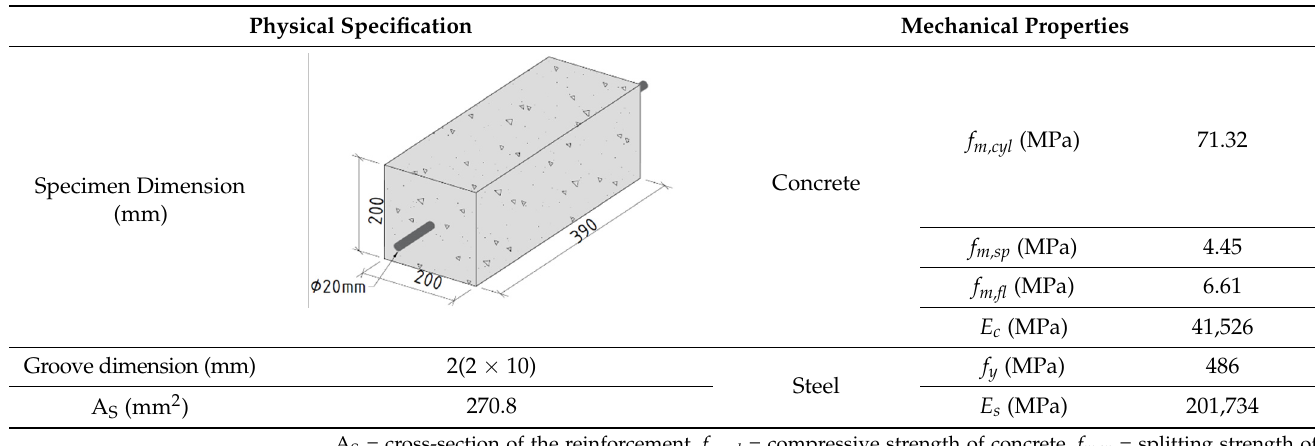
Table 2. Material Characteristics.